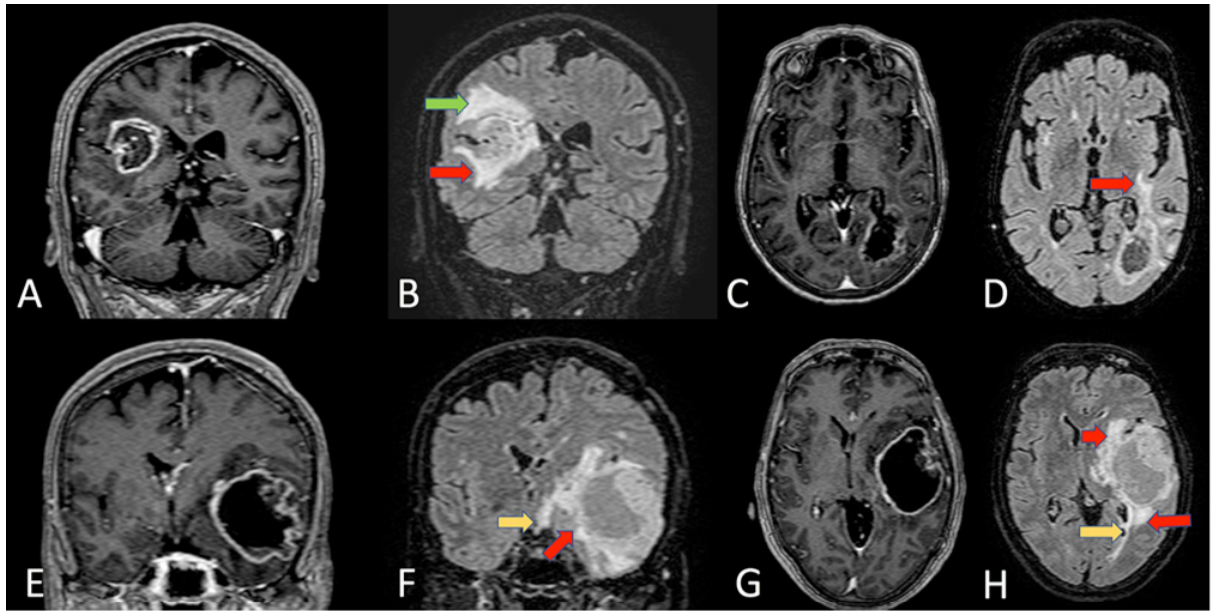
Figure 4. Coronal section of MRI T1 with gadolinium ( A ) and FLAIR sequences ( B ) of a right paratrigonal GBM. In this case, there are clear anatomical relationships between the tumor and lateral wall of the atrium. In the FLAIR sequence, the infiltration of the superior longitudinal fascicle (green arrow) and the inferior fronto-occipital fascicle (IFOF) (red arrow) are visible. In ( C , D ), we can see an axial section of a T1 with gadolinium ( C ) and FLAIR sequences ( D ) of a left paratrigonal GBM. Red arrow ( D ) indicates the IFOF tumoral infiltration at the level of the external capsule. In the lower panels, there is a coronal section of MRI T1 with gadolinium ( E ) and FLAIR sequences ( F ) of a left temporal GBM. In F, the tumoral infiltration of all temporal lobe, of the external capsule, of the IFOF (red arrow) and the omolateral optic tract (yellow arrow) are visible. Axial section of the same patient MRI T1 with gadolinium ( G ) and FLAIR sequences ( H ). Red arrows ( H ) indicate the IFOF tumoral infiltration and yellow arrows indicate the infiltration of optic